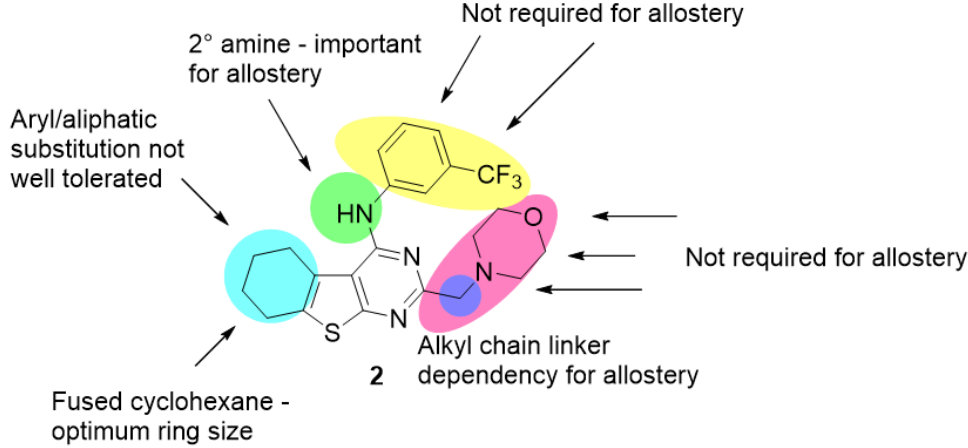
Figure 2. Allosteric D 2 modulator 2 and its structure-activity relationship. Elaborated based on reference [34]. Table 2. Examples of derivatives of compound 2 . a Estimate of the negative logarithm of the equi- librium dissociation constant determined in an cAMP functional assay . b Estimate of the logarithm of the net cooperativity factor between the modulator and dopamine. c Estimate of the logarithm of the modulatory effect upon efficacy factor induced by the allosteric modulator. Values represent the mean ± SEM from at least three independent experiments performed in duplicate.